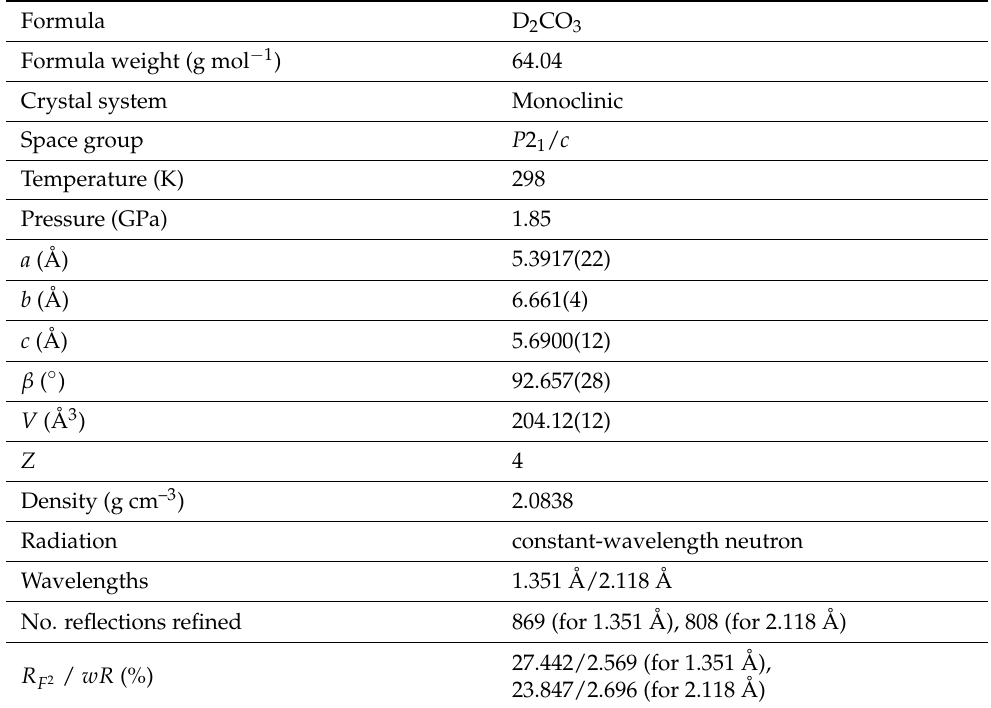
Table A1. Neutron-diffraction based experimentally determined crystallographic data of deuterated carbonic acid.